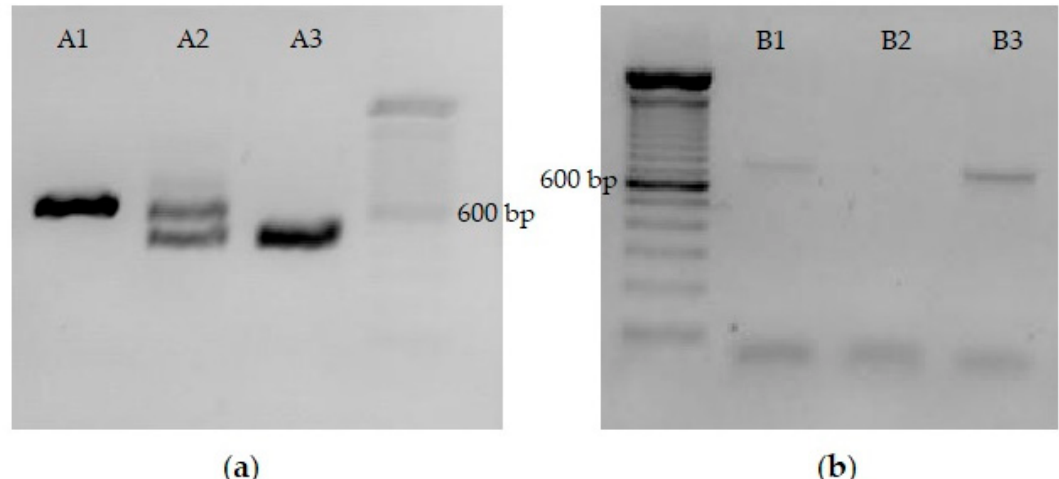
Figure 4. Electrophoresis analyses assessing mating type and mlrA integrated gene on yeasts ( a ) Mating type of tested yeasts: A1—haploid wild-type YRH1636 ( MAT a); A2—diploid strain obtained from YRH1624 recombinant strain mating with YRH1636 wild type; A3—haploid integrated YRH1624 strain ( MAT alpha). ( b ) mlrA gene PCR amplification: B1—diploid+ mlrA integrated strain; B2—YRH1636 (wild type); B3—YRH1624+ mlrA integrated strain.